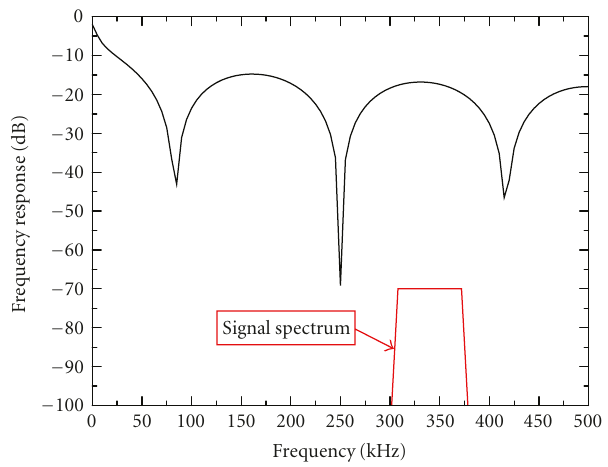
Figure 5: Frequency response of the considered 225 kV power line channel and the transmission spectrum used by the single-carrier PLC system.